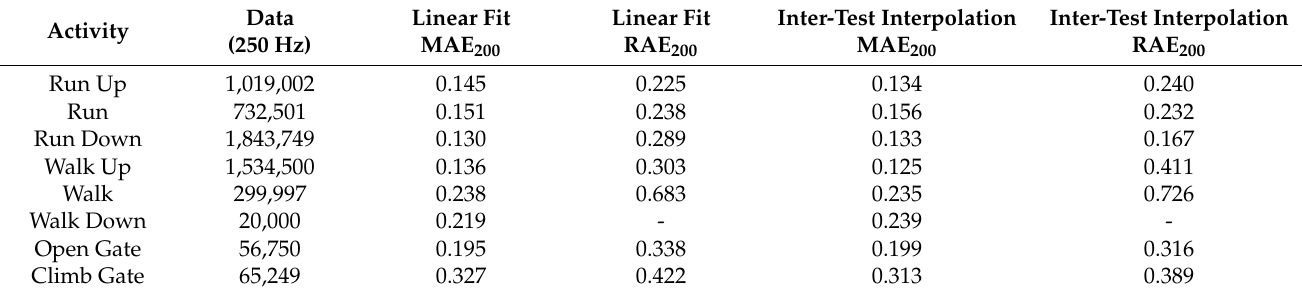
Table 3. Results for linear fit and inter-test interpolated labels.